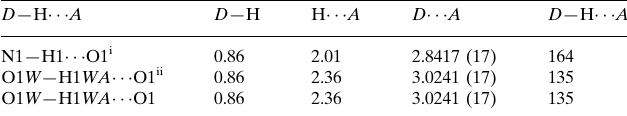
Hydrogen-bond geometry (A˚ , (cid:4)